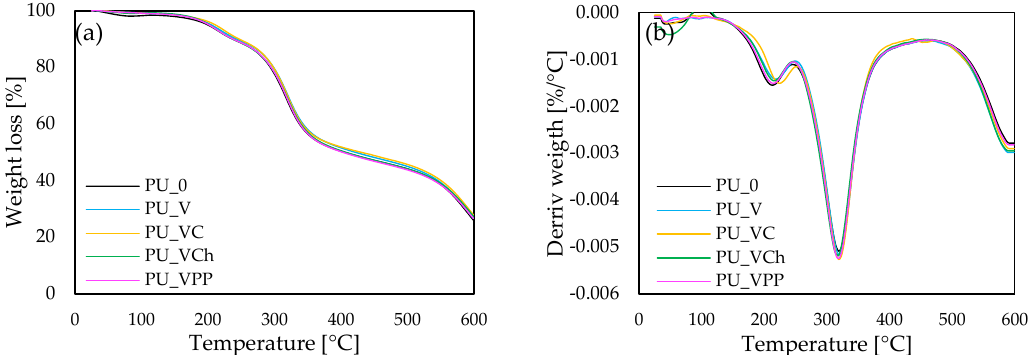
Figure 5. ( a ) Thermogravimetric (TGA) and ( b ) derivative thermogravimetry (DTG) results. Table 3. The results of the thermal stability analysis of the polyurethane composites.